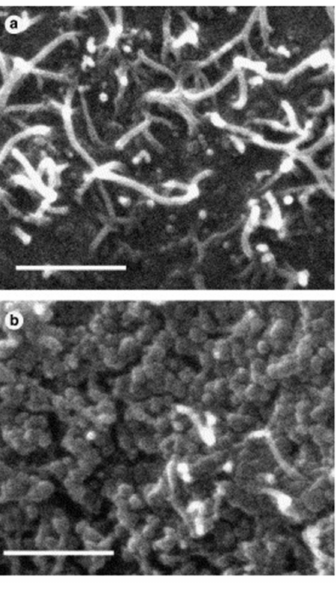
Figure 9. SEM micrographs ( a ) 0.5 wt.% SWCNT/iPP and ( b ) 1.0 wt.% SWCNT/iPP composites [100], reprinted with permission from